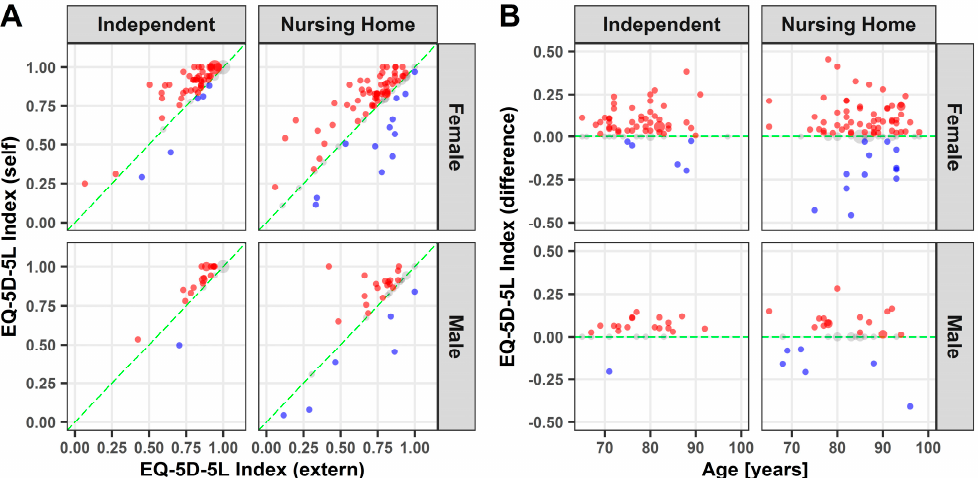
Figure 3. EQ-5D-5L Index: Point plot illustration of self and external assessment of the EQ-5D-5L Index ( A ) as well as the difference against age ( B ). Grey dots: no difference; blue dots: underestimation; red dots: overestimation. Dot size represents the relative number of participants.